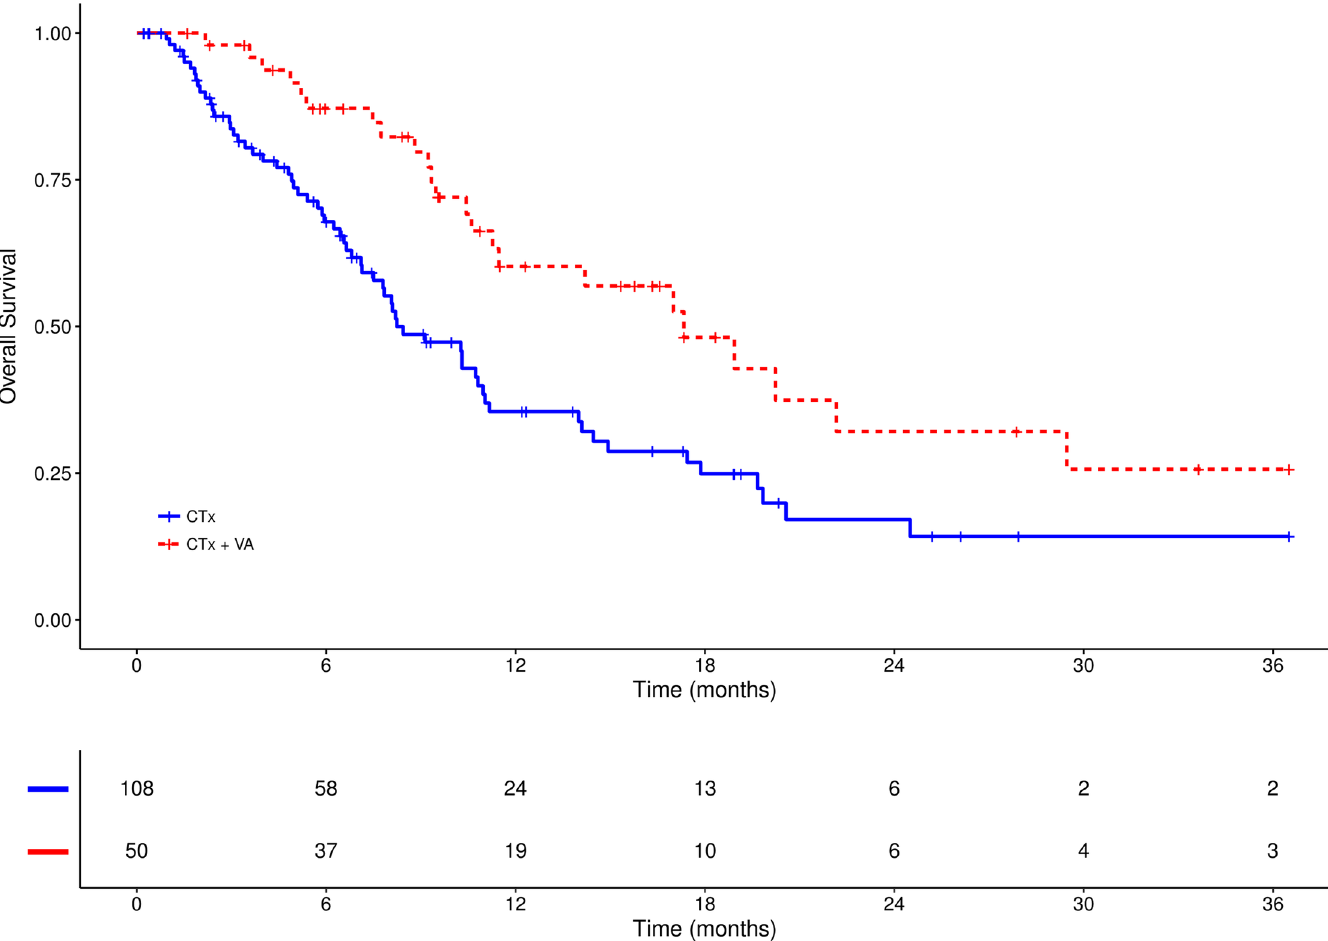
Fig 3. Three-year survival. Kaplan–Meier survival curves displaying 3-year survival in stage IV NSCLC patients treated either with CTx alone or with combinational CTx plus VA, n = 158; CTx, chemotherapy; VA, Viscum album L.